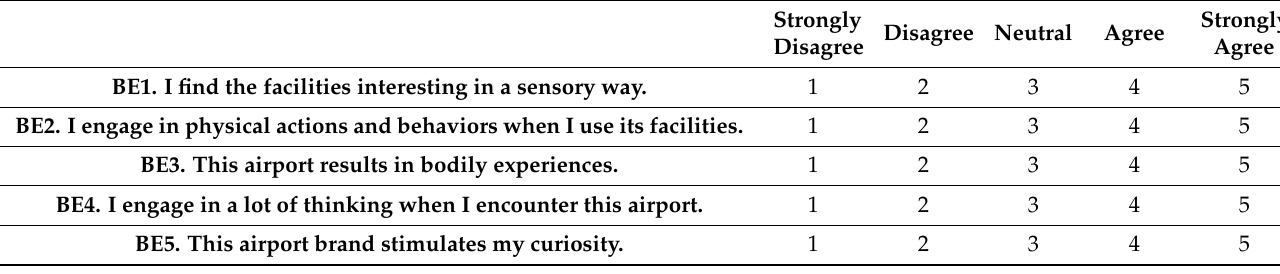
Table A3. Brand Experience.